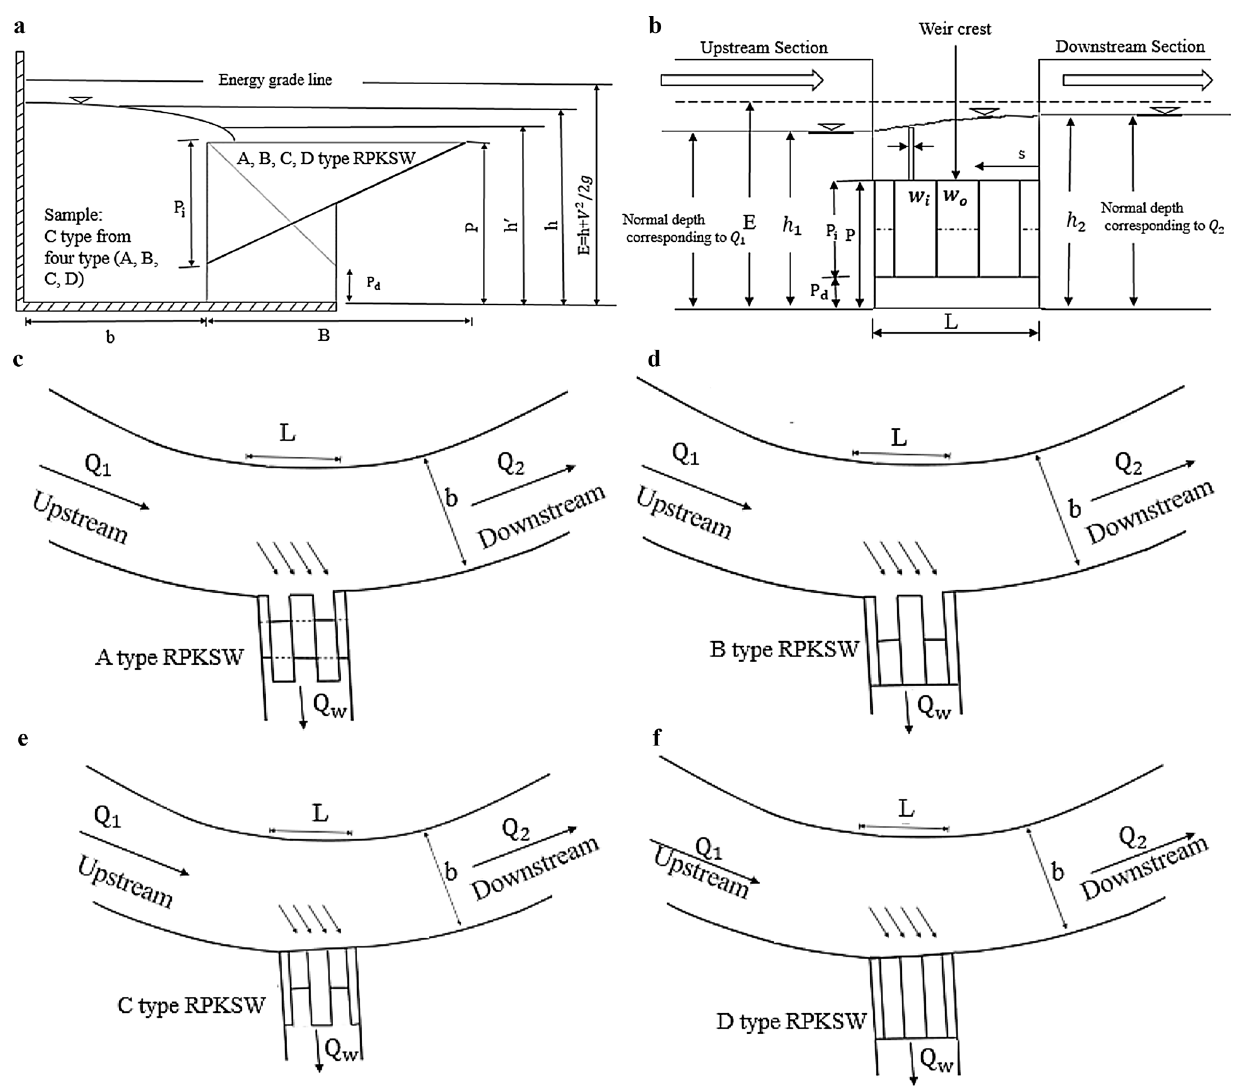
Fig. 3 A schematic view of the